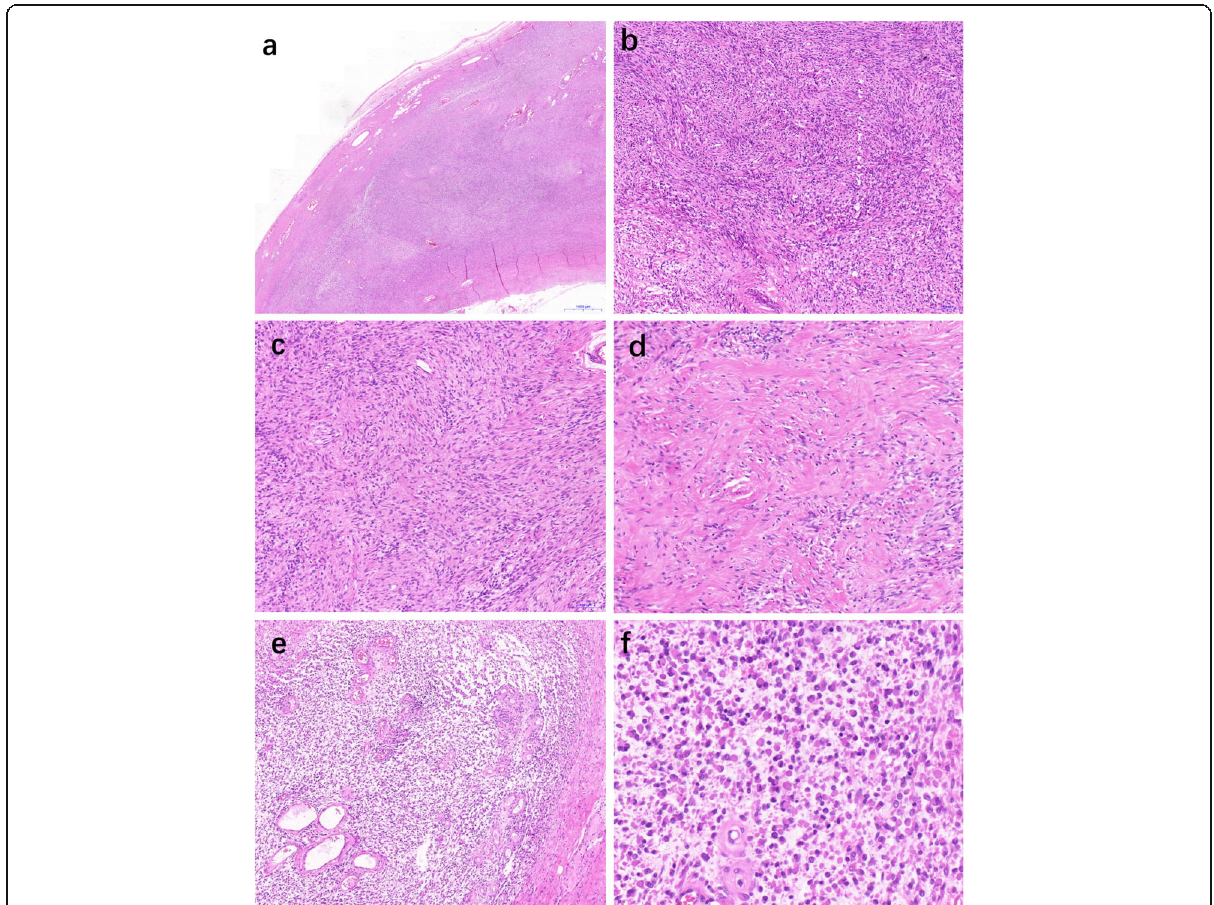
Fig. 1 The tumor was a well-circumscribed nodule, focally encased by a fibrous pseudocapsule ( a ). In nonmyxoid patterns, the spindle-shaped tumor cells formed storiform arrangements, with a combination of hypocellular and hypercellular areas ( b - c ). The fibrous area shows deposition of hyalinizing collagen fibers ( d ). In myxoid patterns, epithelioid tumor cells proliferated singly or in a loosely cohesive reticular manner ( e ), In high power field, the epithelioid tumor cells resembled rhabdomyoblasts ( f